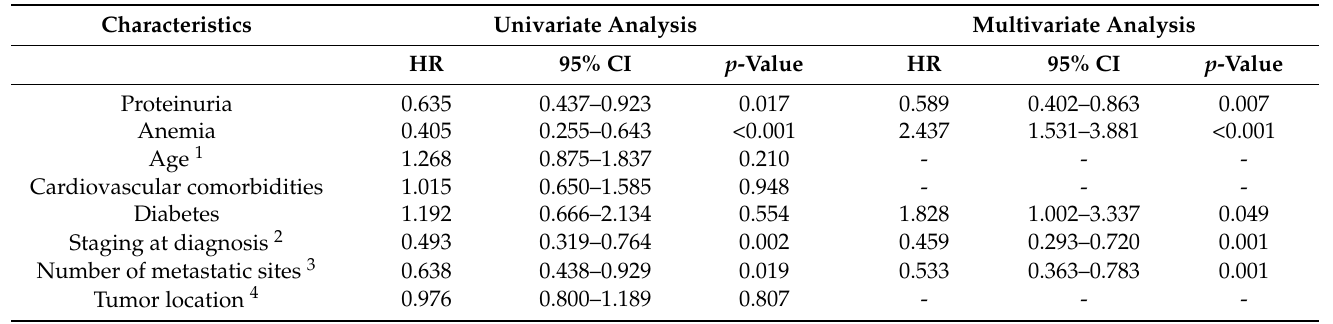
Table 3. Univariate and multivariate prognostic factors for longer OS in metastatic colorectal patients treated with bevacizumab and chemotherapy.